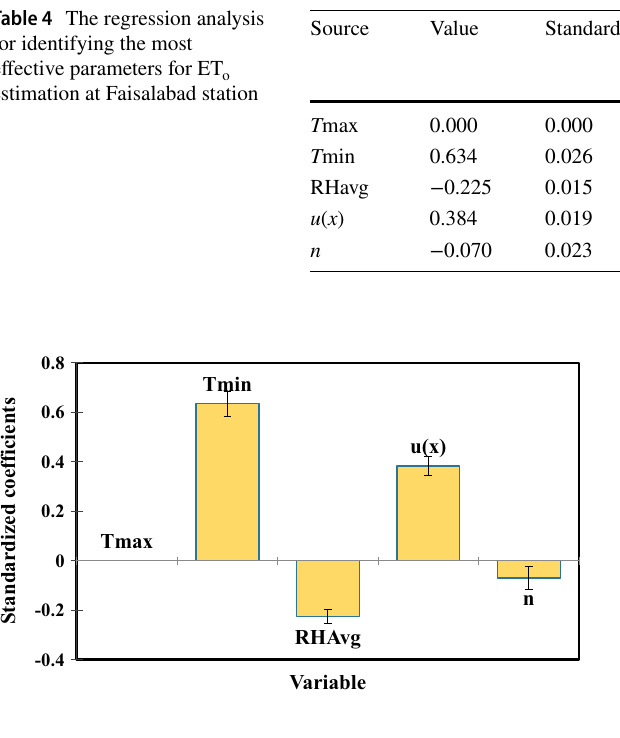
Fig. 2 The standardized coefficients of input variable for sensitivity analysis at Faisalabad station for reference evapotranspiration